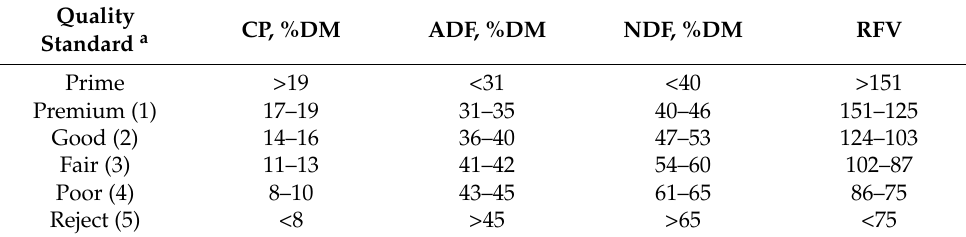
Table 1. Quality standards of legume, grass, and legume–grass